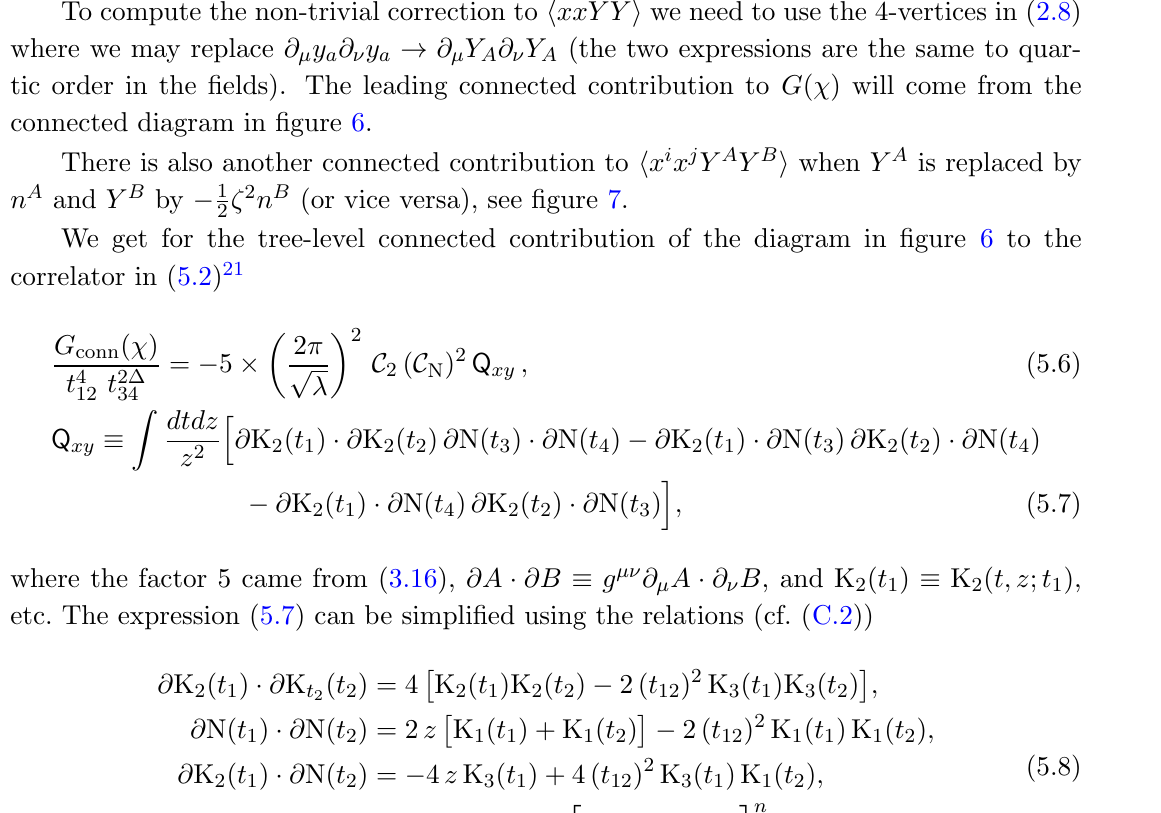
Figure 7 . Connected contribution with Y A replaced by (cid:0) 1 with A $ B